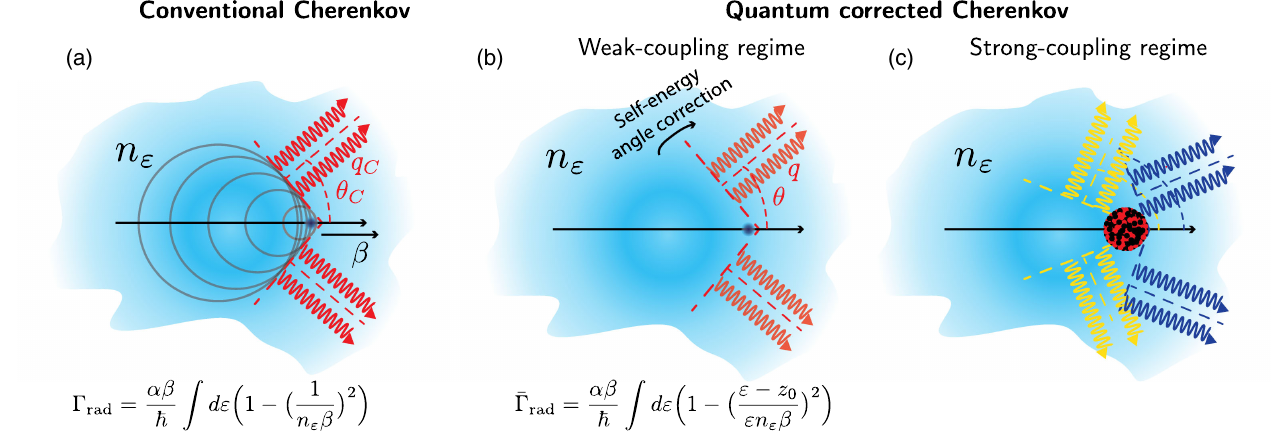
FIG. 1. The quantum Cherenkov effect. (a) Conventional Cherenkov effect. (b) Regularized quantum Cherenkov effect for an electron (weak coupling), where the particle ’ s regularized self-energy is a small correction. (c) Regularized quantum Cherenkov effect for a highly charged ion, where the self-energy results in large